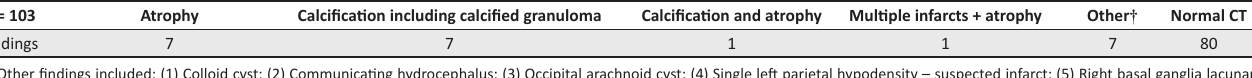
TABLE 2: Distribution of findings documented for computerised tomography scans. N = 103 Atrophy Calcification including calcified granuloma Calcification and atrophy Multiple infarcts + atrophy Other † Normal CT Findings 7